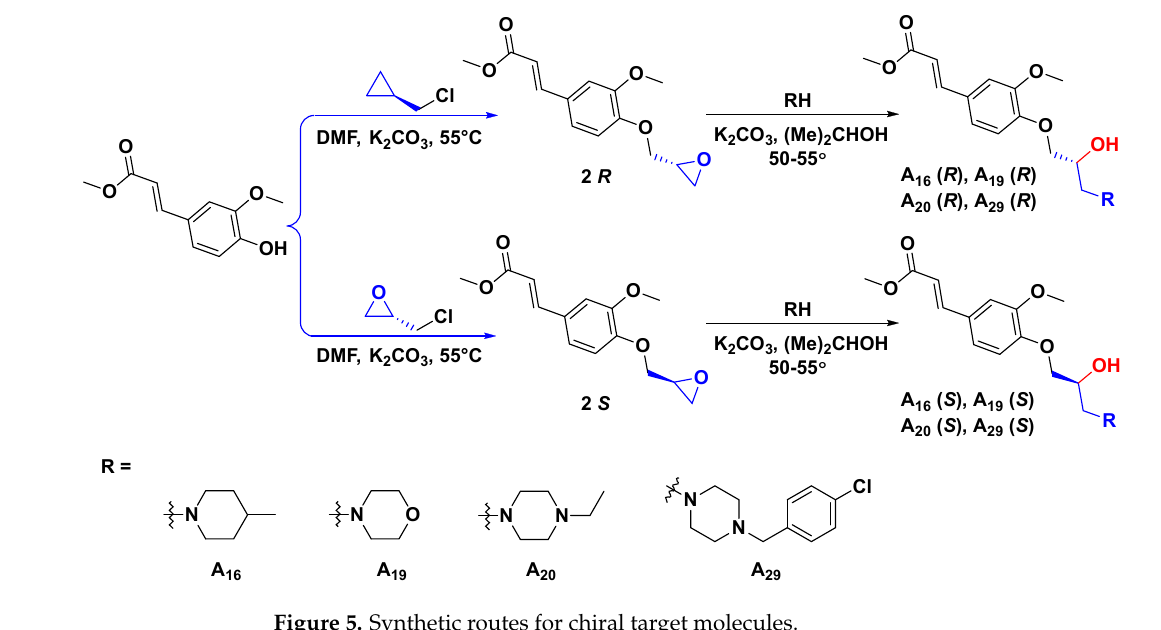
Int. J. Mol. Sci. 2022 , 23 , x FOR PEER REVIEW Figure 5. Synthetic routes for chiral target molecules. Figure 5. Synthetic routes for chiral target molecules.